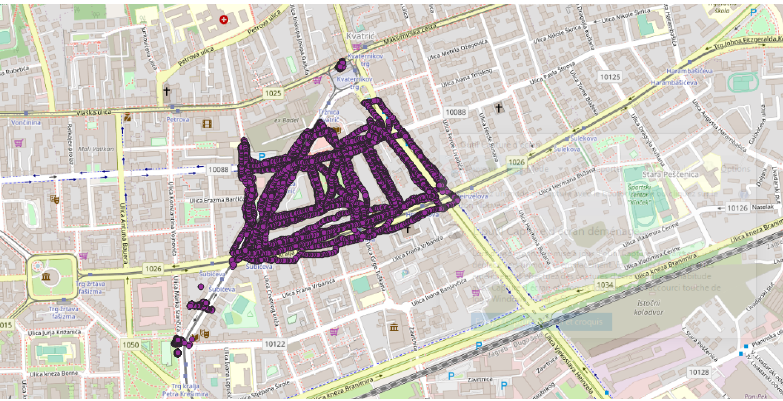
Figure 12. Representation of the cluster found as part of the event (3 tracks/6417 points) in Zagreb (Croatia), in March 2018 [46] ; represented area of approximately 1 km × 2 km. All the data are extracted from the NoiseCapture database [41].